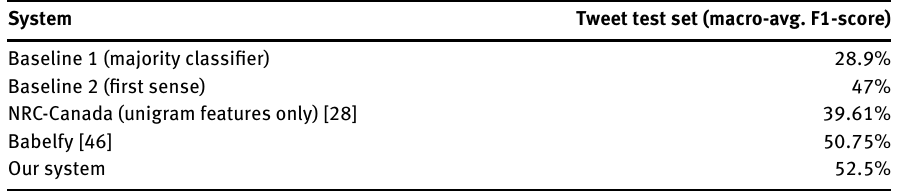
Table 7: The Macro-Averaged F1-Score on SemEval-2013 Test Set for Positive and Negative Classes Only. System